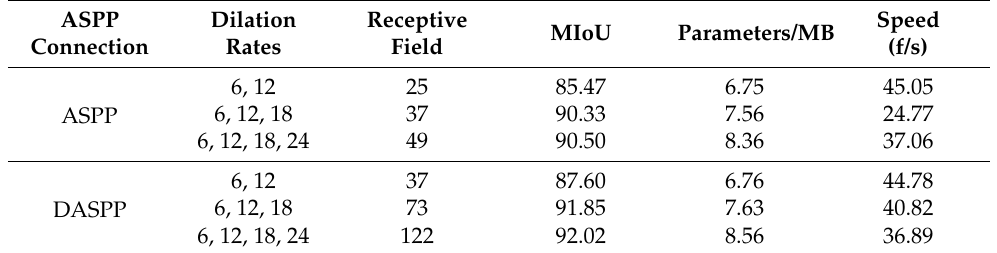
Table 6. Comparison of the influence of different ASPP connection methods and dilation rates.